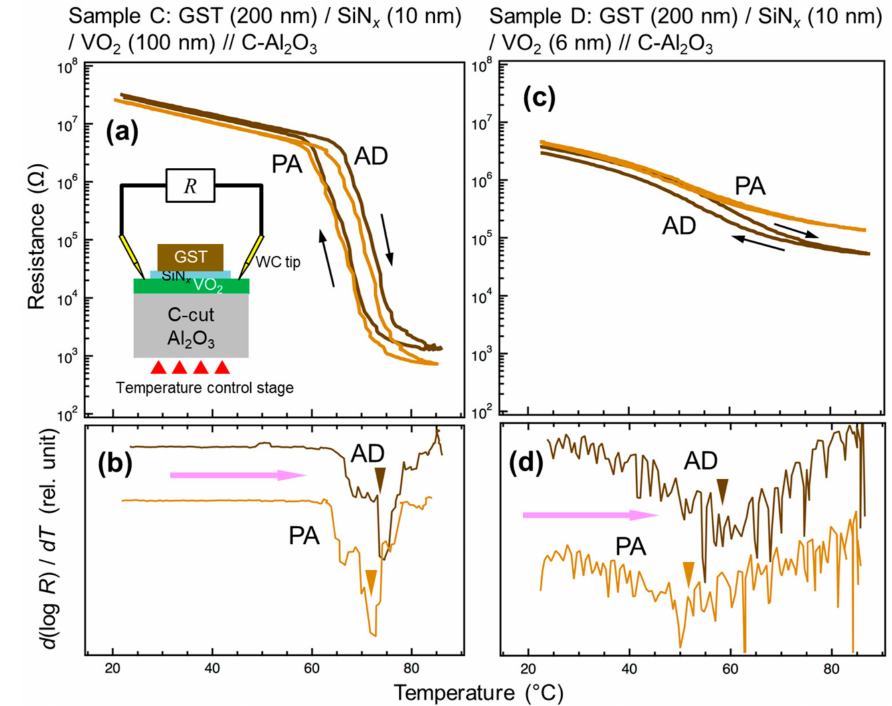
Figure 4. ( a – d ) Temperature dependence of electrical resistance ( a , c ) and temperature-di ff erential profiles of the logarithm of the resistance [ d (log R ) / dT ] in the heating runs ( b , d ) for Sample C ( a , b ) and Sample D ( c , d ) at AD and PA steps. Inset of ( a ) schematically shows the measurement configuration. The triangle symbols indicate the valley position.